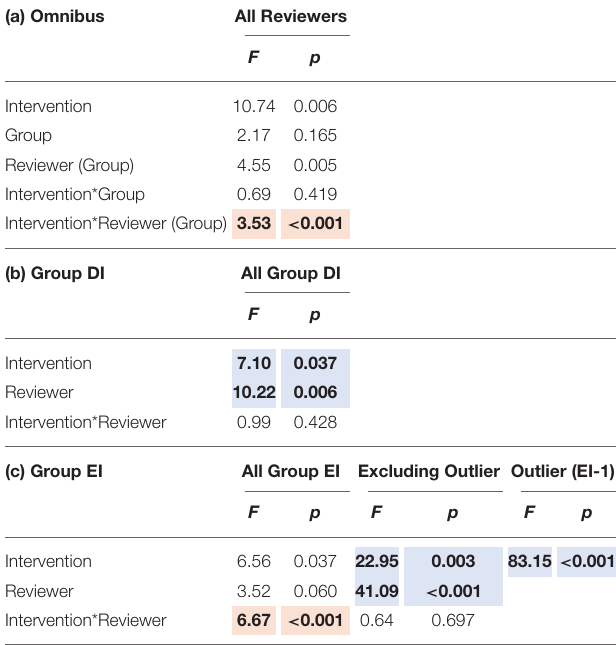
TABLE 2 | Summary of ANOVAs for intervention, reviewer, and group, including F statistics and p -values for each effect and their